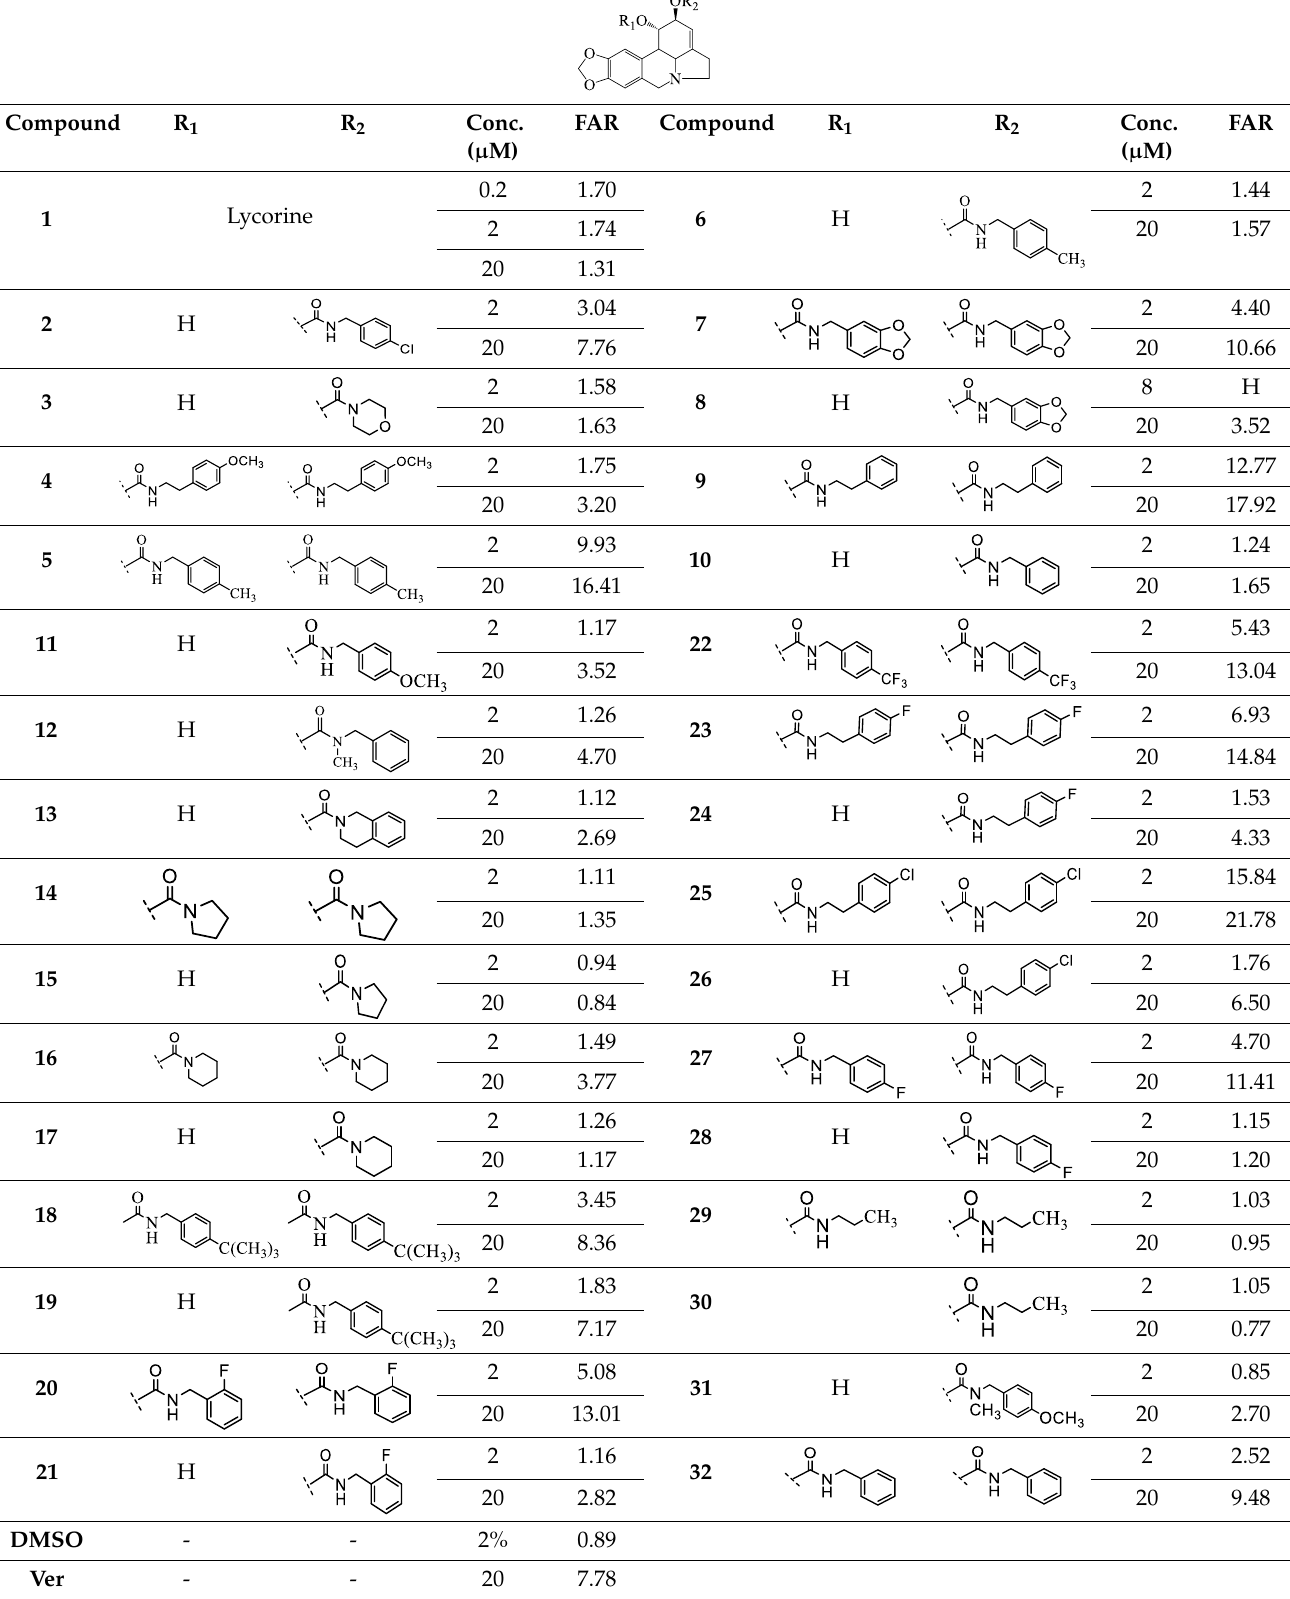
Table 2. P-gp inhibitory activity of parental compound 1 and derivatives 2 – 32 in resistant human colon adenocarcinoma cells (Colo320).